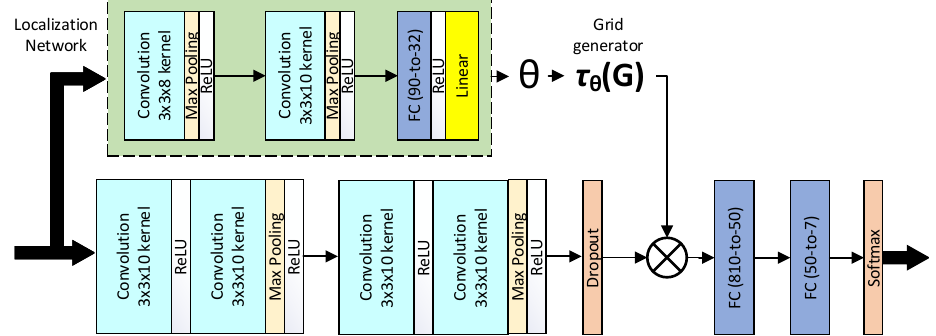
Figure 3. The proposed model